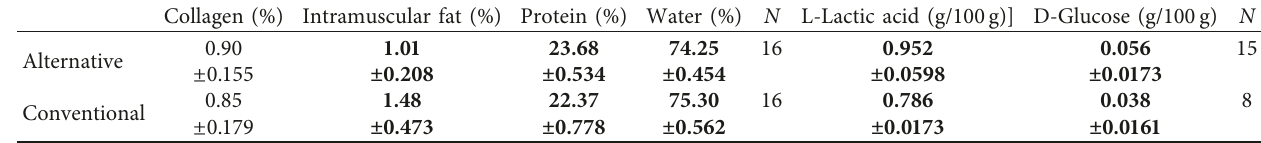
Table 1: Analysis of nutrients in the alternative and conventional production line, mean values, and standard deviations.